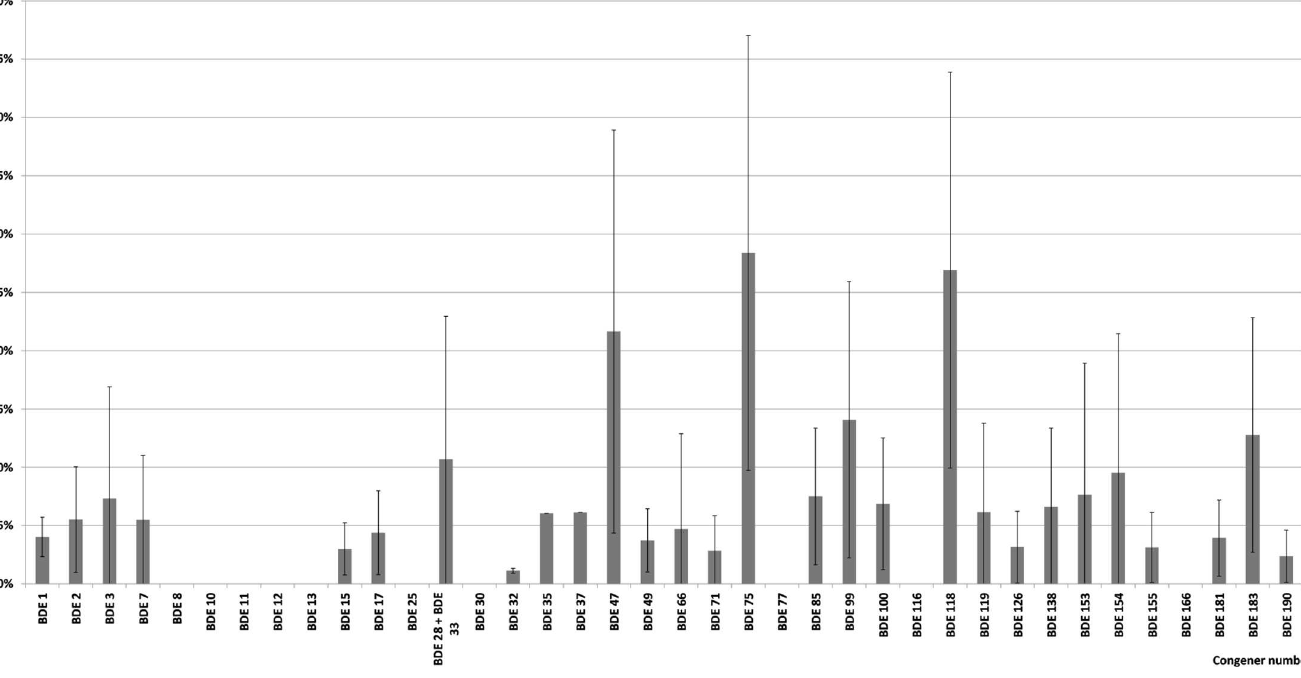
Fig 5. Profile of congeners found in BDE-positive bee pollen